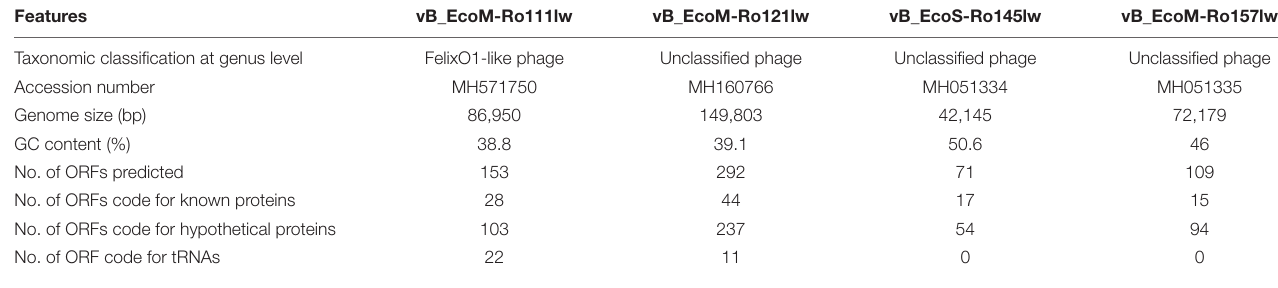
TABLE 3 | Genomic features of the STEC-specific bacteriophages from non-fecal composts.